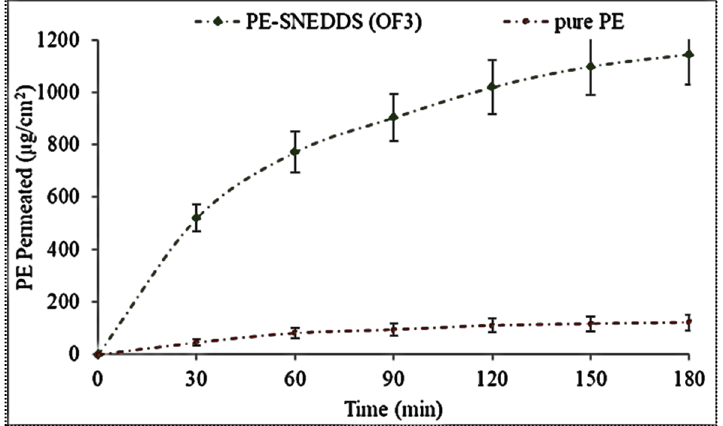
Figure 5. Ex vivo permeation profile of PE-SNEDDS (OF3) and pure PE dispersion. Values are given as mean ± SD ( n = 3).